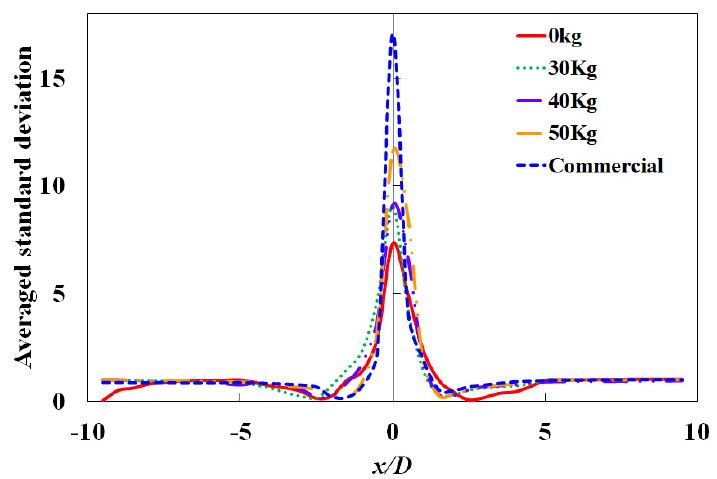
Figure 13. Normalized standard deviation of the spraying amount in various radial positions. The values are normalized by the averaged spraying amount.